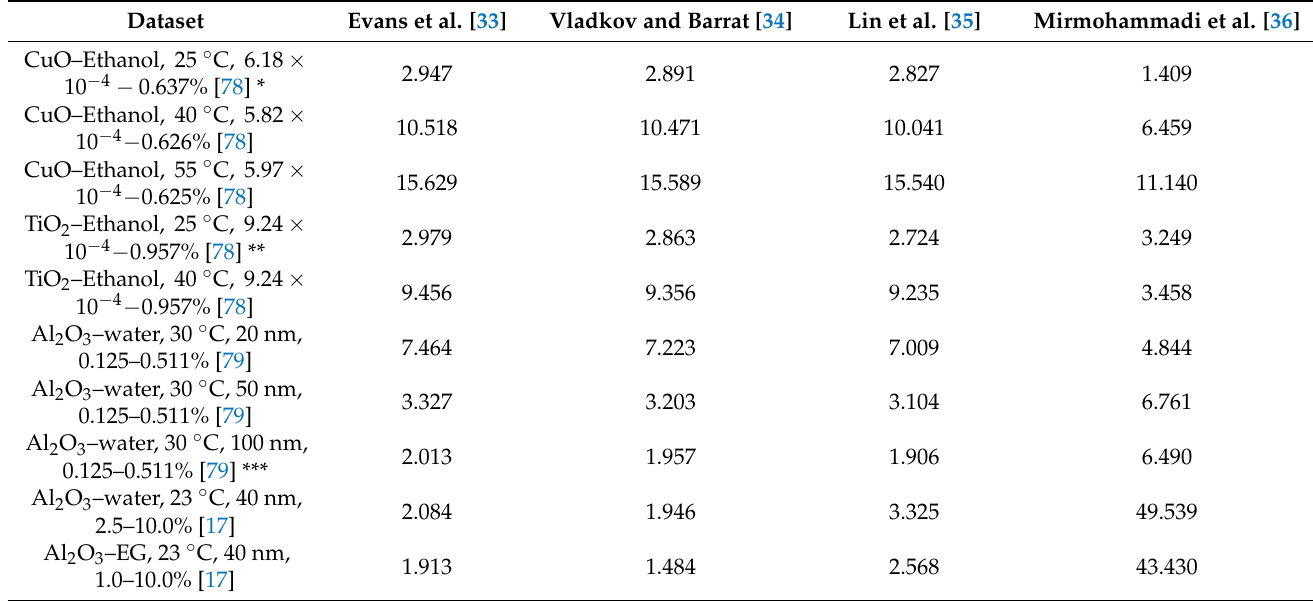
* Experimental data used in Figure 10; ** Experimental data used in Figure 11; *** Experimental data used in Figure